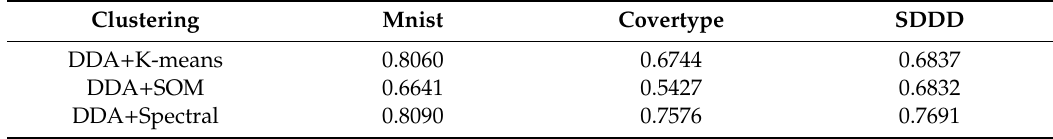
Table 3. Consistent accuracy index ( CAI ) comparisons between di ff erent algorithms.